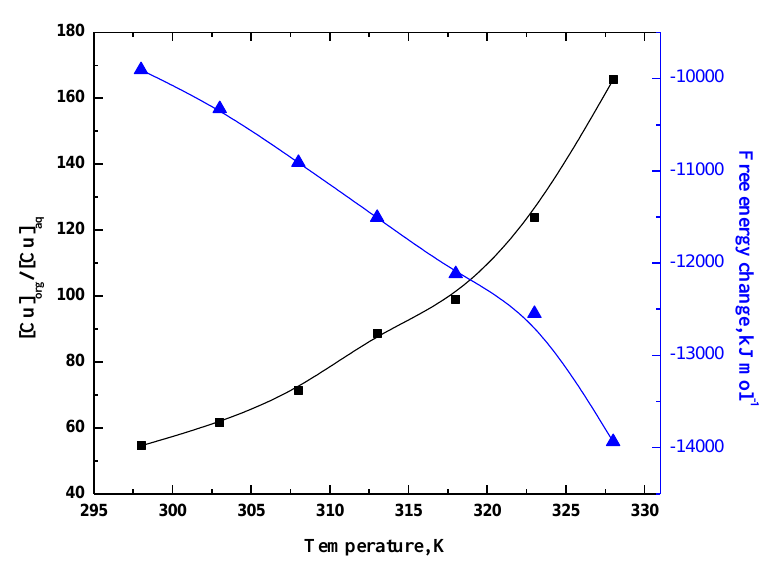
Fig. 6. Effect of temperature on free energy change (ΔG) and distribution coefficient (D).